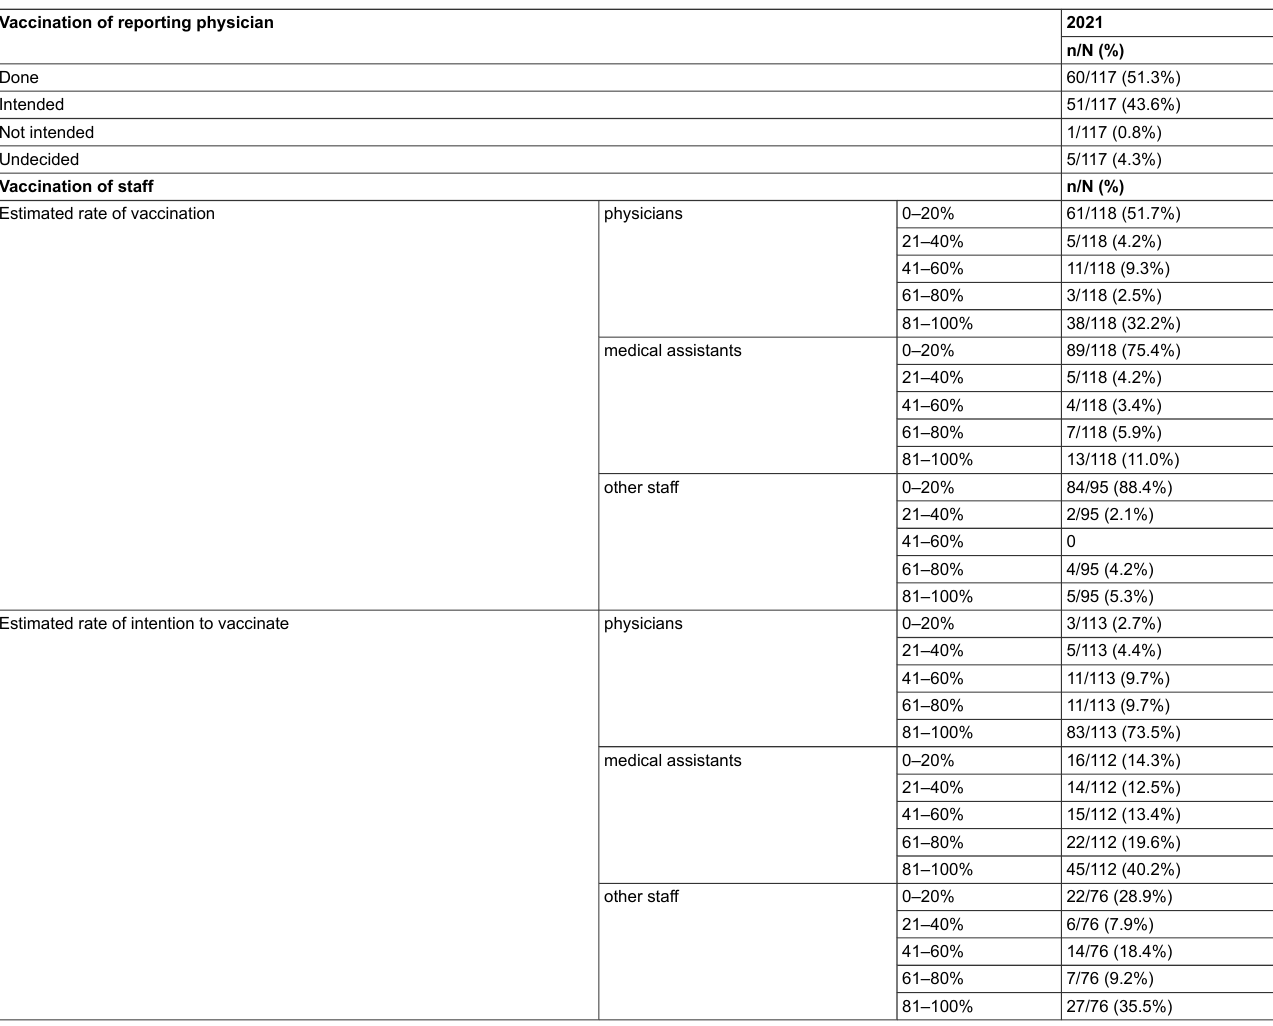
Table S1: SARS-CoV-2 vaccination and vaccination intention in Sentinella network practices in 2021 (127 answering practices).